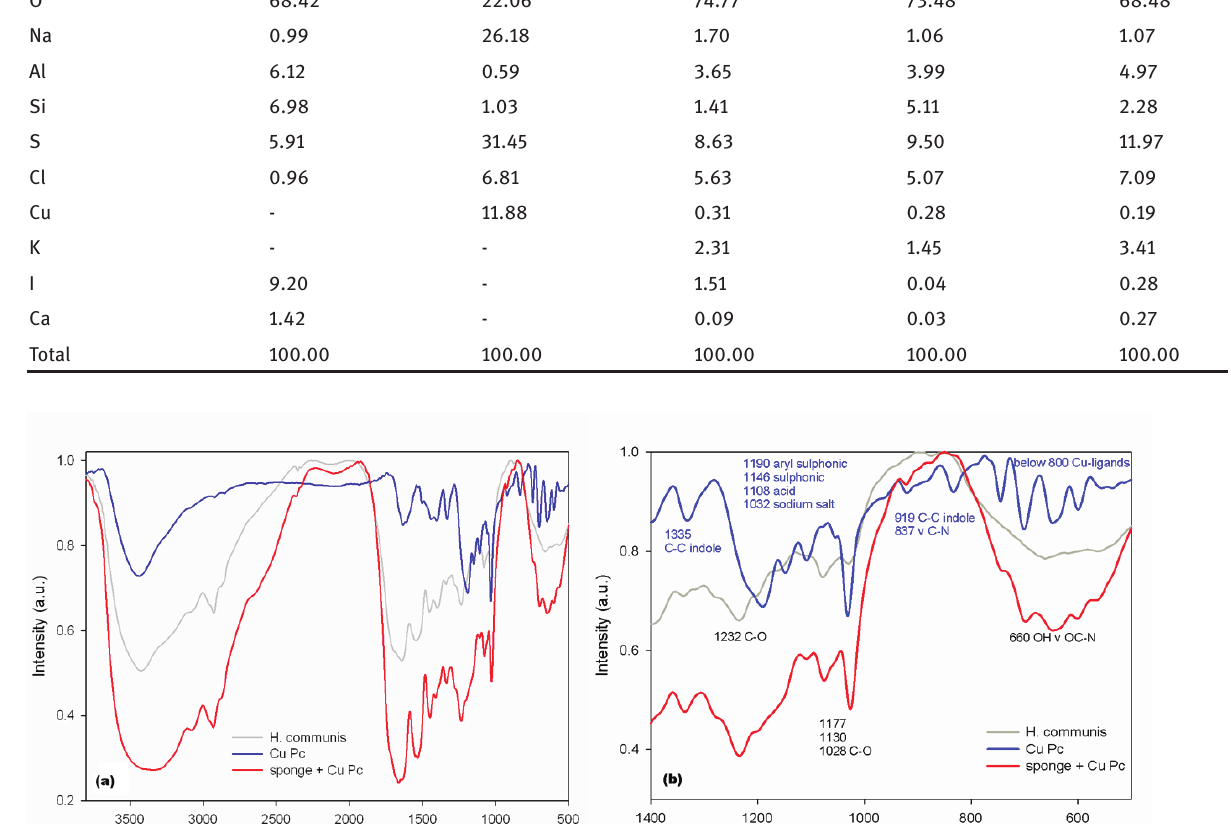
Table 2: Quantification of elements in the analyzed marine sponge skeleton, copper phthalocyanine and selected samples. Element content (wt.%)